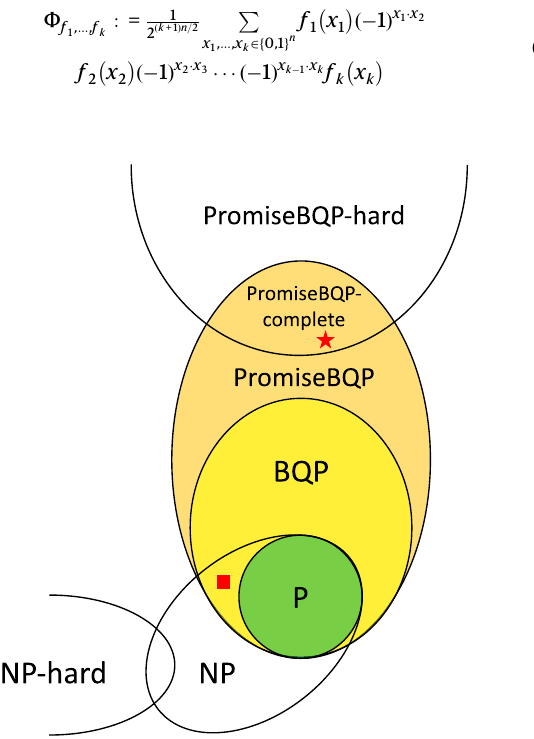
Fig.1|Hierarchyandrelationsofthecomplexityclassesandproblemsrelevant for this work. This includes the discrete logarithm decision problem DLP 1/2 (red square) and (explicit) k -F ORRELATION promise problem (red star). We use the fol- lowing established, but not yet proven, assumptions: DLP 1/2 in NP, P ≠ NP, P ≠ BQP ( ⇒ existence of quantum advantage), NP-complete is outside BQP, (P ROMISE )BQP- complete is outside